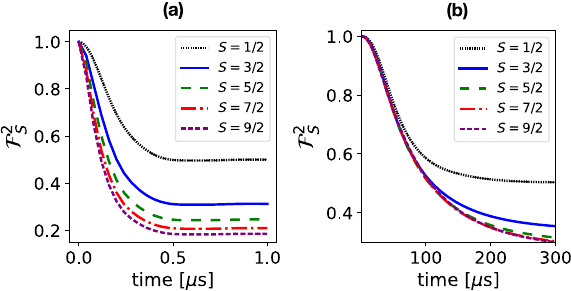
Fig. 2 Inhomogeneous broadening and spin echo. a Decay of the squared fi delity with respect to the initial state under inhomogeneous broadening for different spins S initialized in a state ψ L j i ¼ ð 0 L j i ffiffiffiffiffiffiffi p , where 0 L j i and 1 L j i are spin-binomial codewords þ i 1 L j iÞ = ð 2 Þ corresponding to spin S 13 (see also “ Methods ” ); the results have been averaged over 2 6 initial spatial con fi gurations of the nuclear spins, as explained in “ Methods ” . b Decay of the echo squared fi delity for the same initialization of ( a ). For each time point t , a generalized echo transformation of the form e (cid:2) i π ^ S x at t /2 is